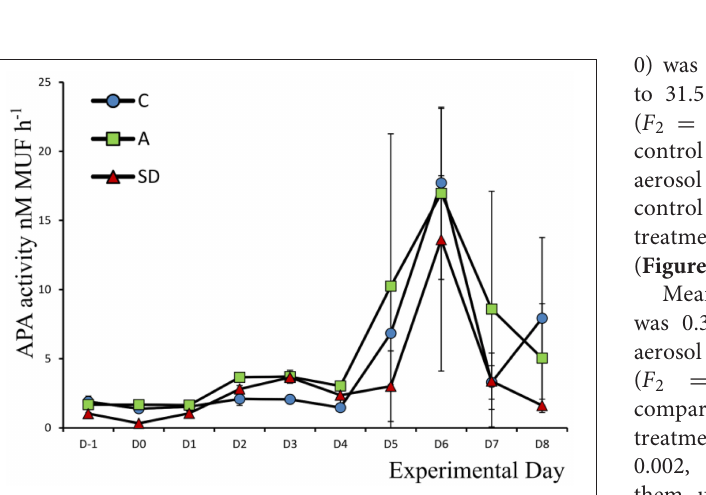
treated mesocosms was mostly due to changes in the fractions from 0.6–2 and > 2 µ m ( Figures 6B–D